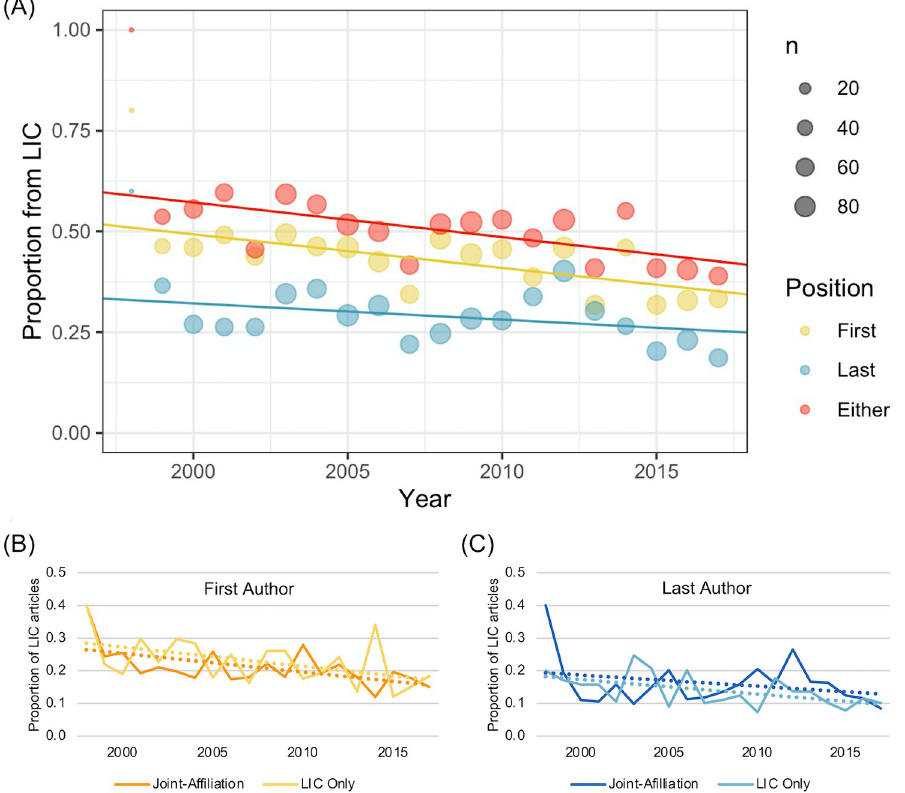
Fig 2. Proportion of LIC-affiliated first and last authorship over time. (A) Overall proportion of LIC-affiliated first, last and first or last authorship. Number of articles per year is represented by the size of the corresponding circle. (B) Proportions of LIC-affiliated and jointly-affiliated first authors. (C) Proportions of LIC-affiliated and jointly-affiliated last authors. Abbreviations: LIC, low-income